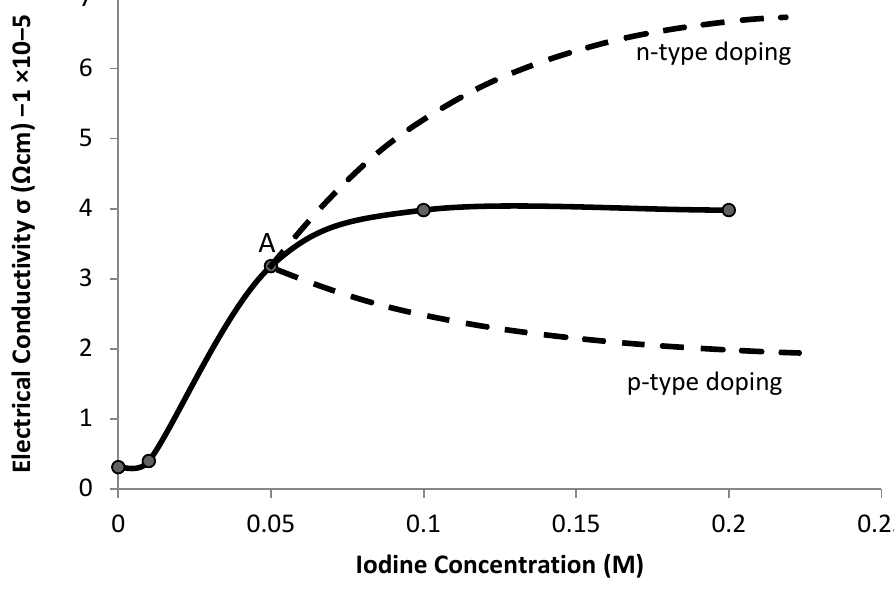
Figure 3. Typical variation of electrical conductivity (σ) of CdTe as a function of increasing iodine concentration in the electrolytic bath. Note the initial n-type doping and final saturation of σ, as a result of triggering of p-type doping at point A, due to high iodine concentration. Self-compensation mechanism sets the final conductivity